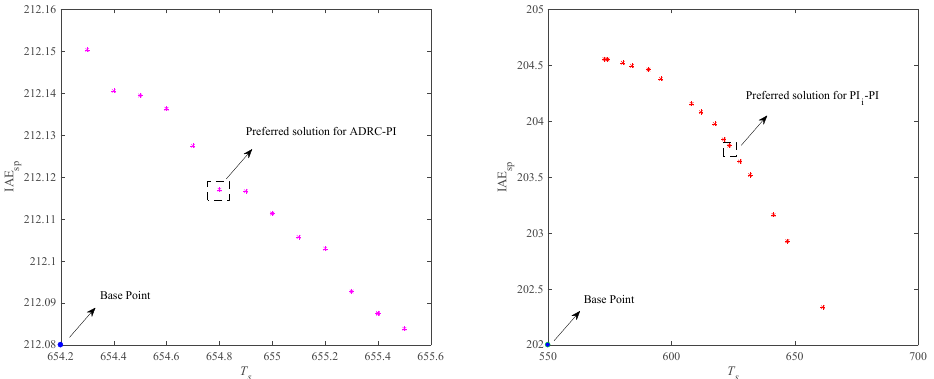
Figure 17. The preferred solutions for parameters of ADRC-PI and PI i -PI.